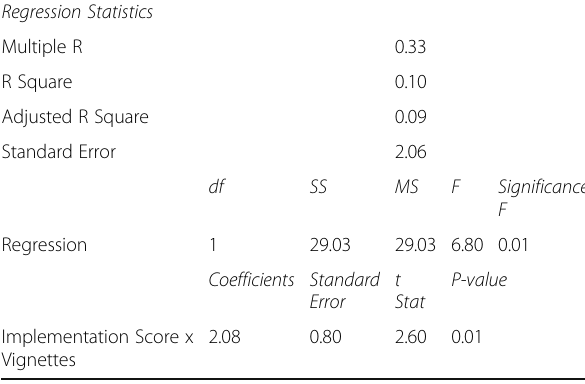
Table 4 ANOVA: Regression Statistics comparing Implementation scores and Vignette scores ( n = 58) Regression